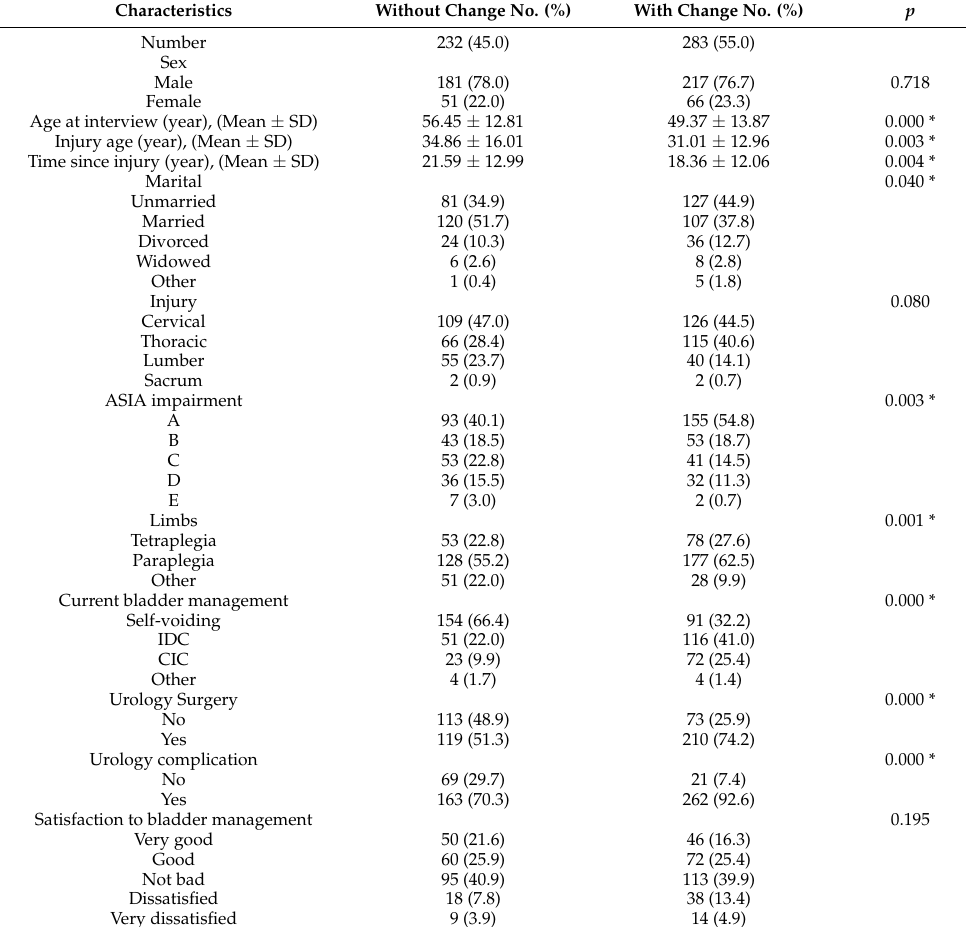
Table 3. Patients with or without a change in bladder management of 515 patients with spinal cord injury. Characteristics Without Change No. (%) With Change No. (%) p 232